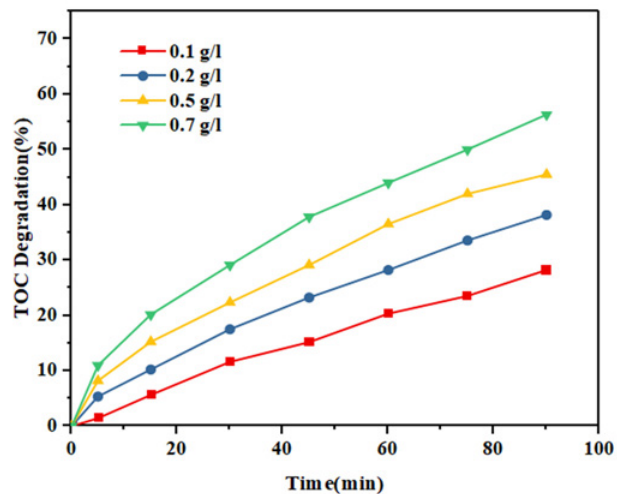
O / ZnO / Ag composite nanoparticles 3 4